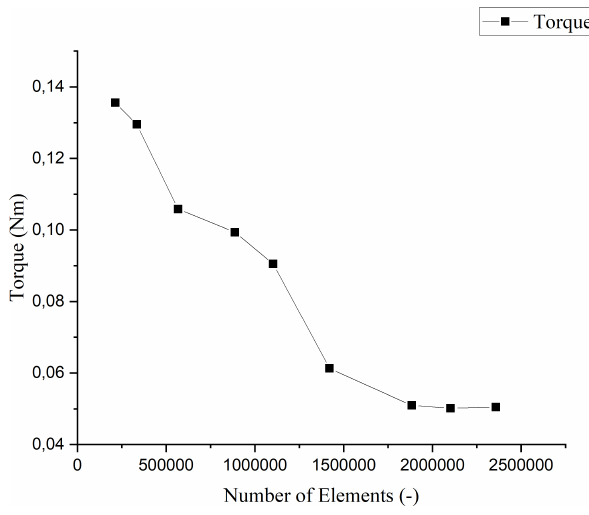
Figure 4: Graph the relationship between the number of elements and